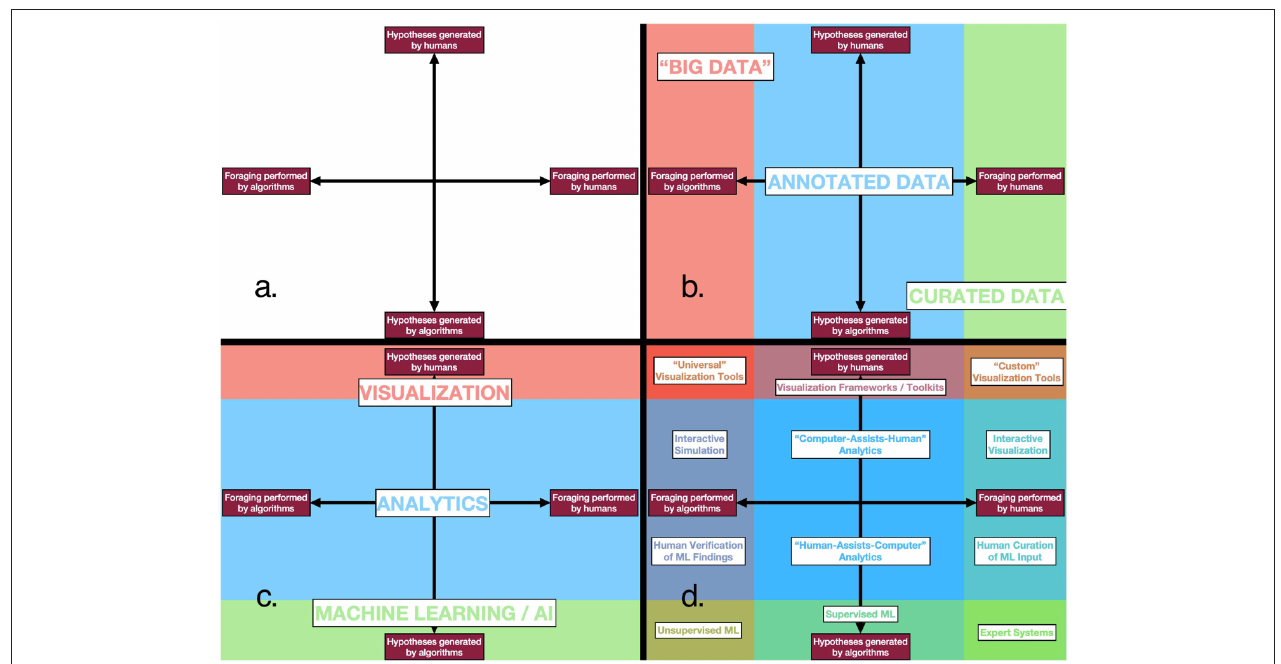
FIGURE 2 | (a) The “space” of (immersive) analytics, inspired by the definition proposed in section 2. (b) One possible partitioning of the space, based on the amount of human processing involved in its collection. (c) Another possible partitioning of the space, based on whether the knowledge generation is being done primarily by humans or algorithms. (d) A partitioning of the space resulting from the combination of (b,c) , populated with analytic processes that illustrate the different